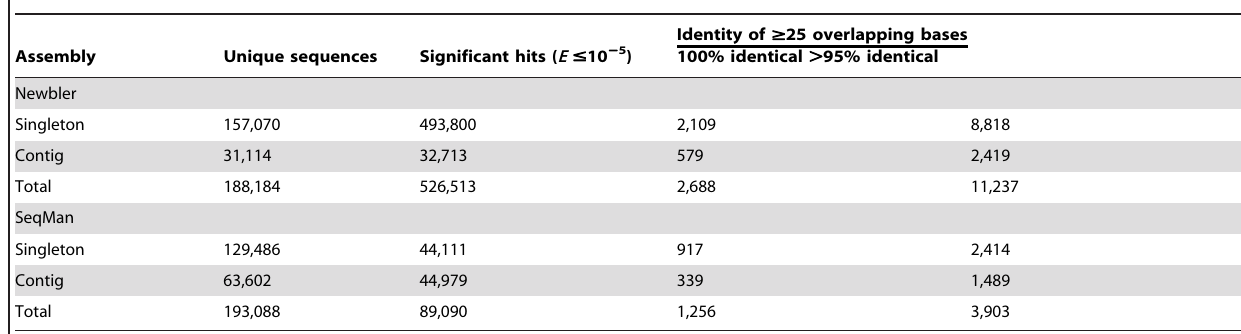
Table 1. Completeness test of two 454 sequence assemblies using BLASTN a